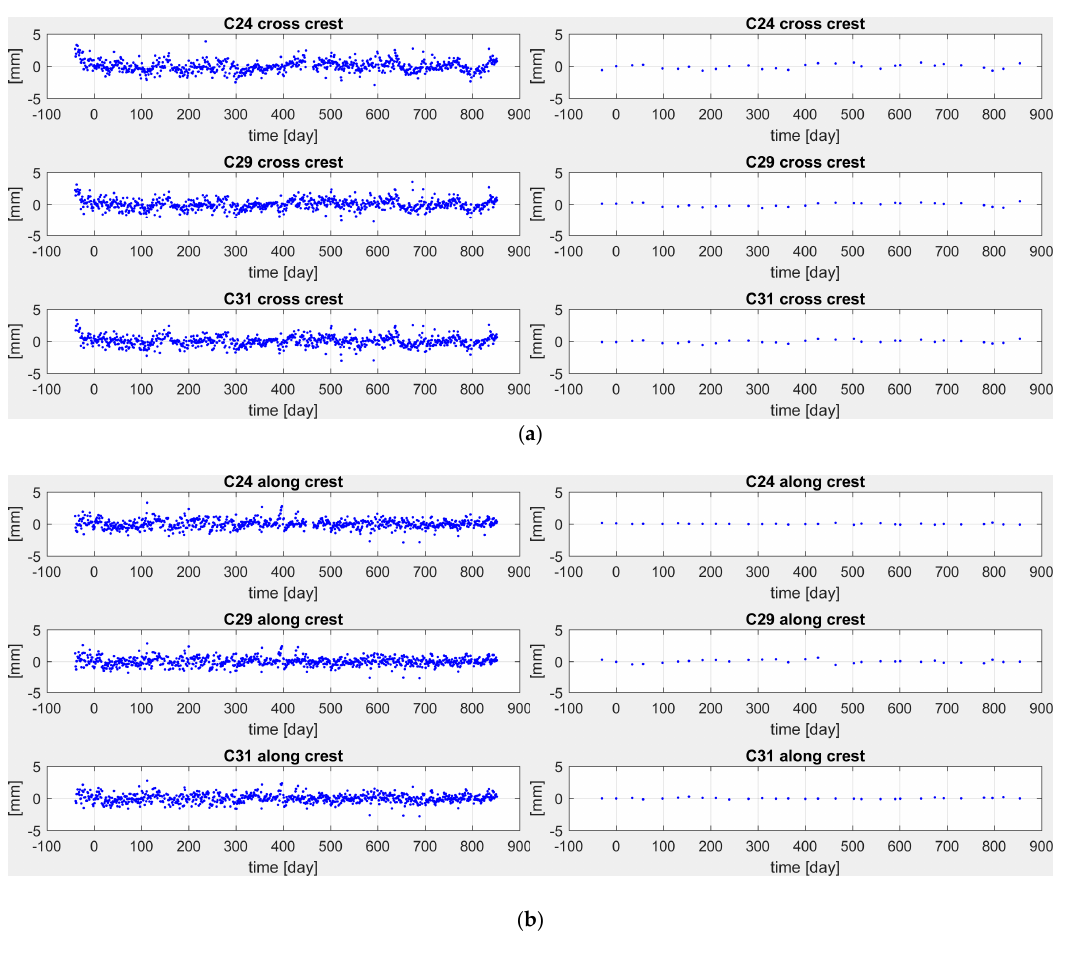
Figure 9. ( a ) Residuals of estimated models in the cross-crest direction by GNSS ( left ) and pendulums ( right ). ( b ) Residuals of the estimated models in the along-crest direction by GNSS ( left ) and pendulums ( right ). Table 1. Standard deviation of the differences between the observations and the corresponding models.